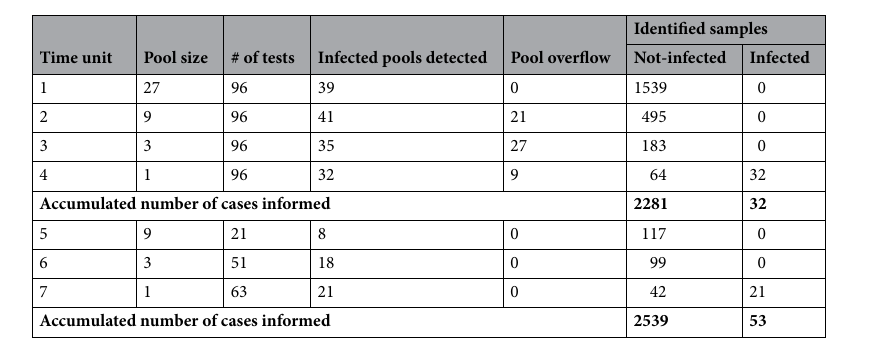
Figure 5. Expected number of tests per stage. ( a ) Expected number of tests, ET 2 j k , as a function of p for strategies of the form m ≤ ≤ 4 (blue). The thicker portion of the curves correspond to the values of p for which each of the (green) and k = schemes is optimal. The horizontal line in magenta corresponds to the number of tests at the first stage ( j for all k . ( b ) Ratio of the number of tests expected for two subsequent stages, ET ( 3 k , . . . , 3 ) and k strategies with m = (µ k µ , . . . , µ , p k ) , as a function of j for µ ET ( j ) ( c ) ET ( j , µ) k = (magenta). We plotted the curves for any value of j , but only integer ones are meaningful.